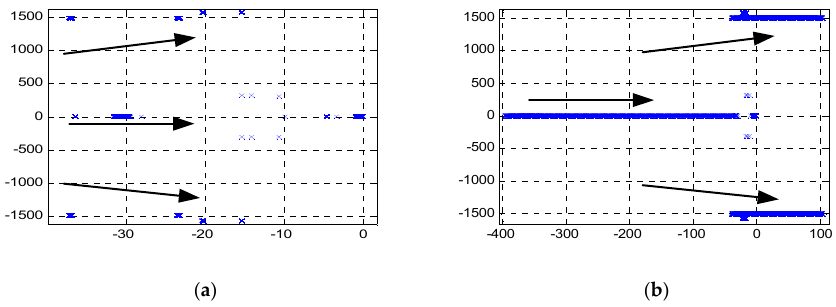
Figure 7. ( a ) The system root locus varies along with active power drooping coefficient m ph variation under the h th harmonic frequency; ( b ) The system root locus varies along with reactive power drooping coefficient n qh variation under the h th harmonic frequency.